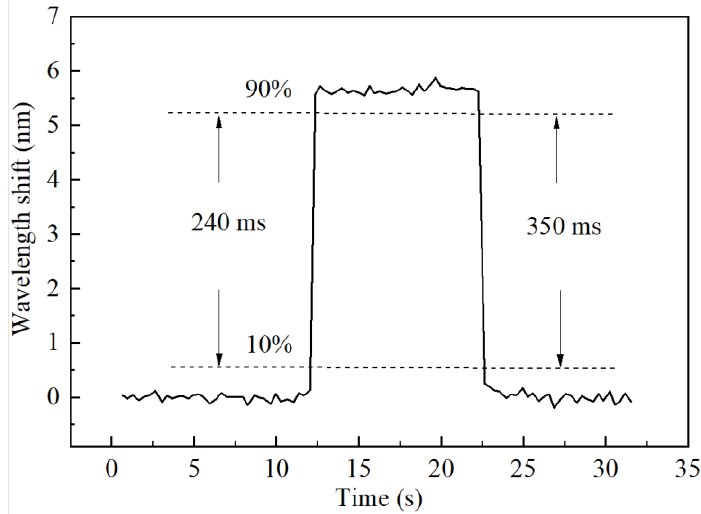
Figure 9. Dynamic performances of the FPI probe. Table 1. Performance comparison of some reported optical fiber humidity